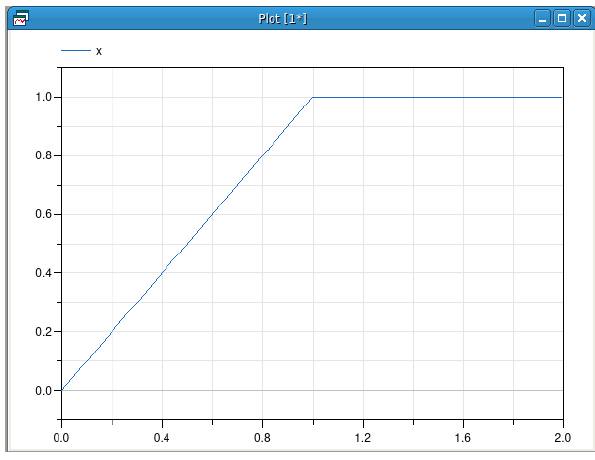
Figure 28. Simulation of the Two Equations model in RIMIS form with Dymola